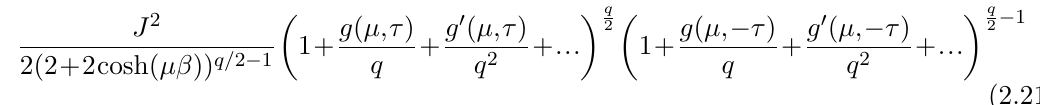
Figure 1 . A diagrammatic representation of (cid:6). Each vertex is worth of strength J , and propagators run inside the loop in each direction. The direction of the arrows correlate with the sign of (cid:28) in the argument of the propagators. The overall direction of the diagram, from left to right, selects out two additional propagators running in this direction and hence the corresponding powers of G